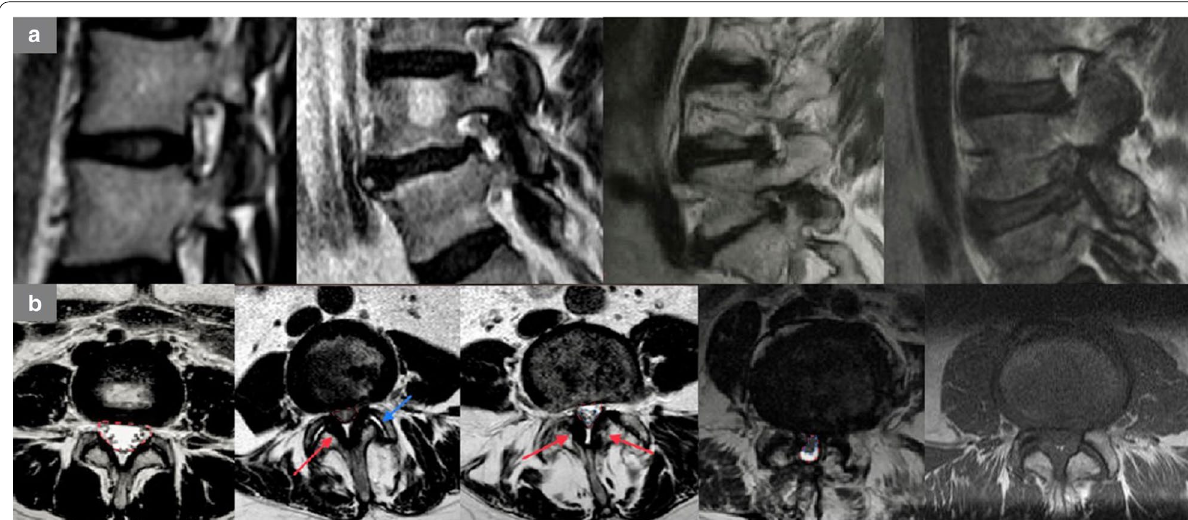
Fig. 5 a Classification of foraminal stenosis on sagittal T2-WI starting from normal findings (Left) to stenosis (Right): normal width of the foramina; slight stenosis; moderate stenosis; severe stenosis. b Classification of spinal canal stenosis on axial T2-WI starting from normal findings to stenosis. From Left to Right: Grade 0, normal width of the spinal canal, no stenosis; Grade 1, slight stenosis, without significant aggregation of the nerve roots (the reduction in size of the canal is due to bilateral hypertrophy of the ligamentum flavum—red arrow; a bilateral facet fluid joint collection is also associated—blue arrow); Grade 2, moderate stenosis (bilateral hypertrophy of the ligamentum flavum—red arrow. Nerves of cauda equina are aggregated, but cerebrospinal fluid—CSF—is still evident); Grade 3, severe stenosis (entire cauda equina appears as a bundle due to all degenerative processes’ compression, but posterior epidural fat is still visible); Grade 4, extreme severe stenosis (no rootlets and posterior epidural fat are